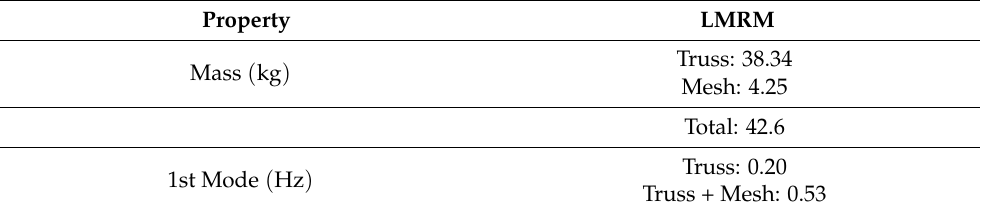
Table 2. Reflector